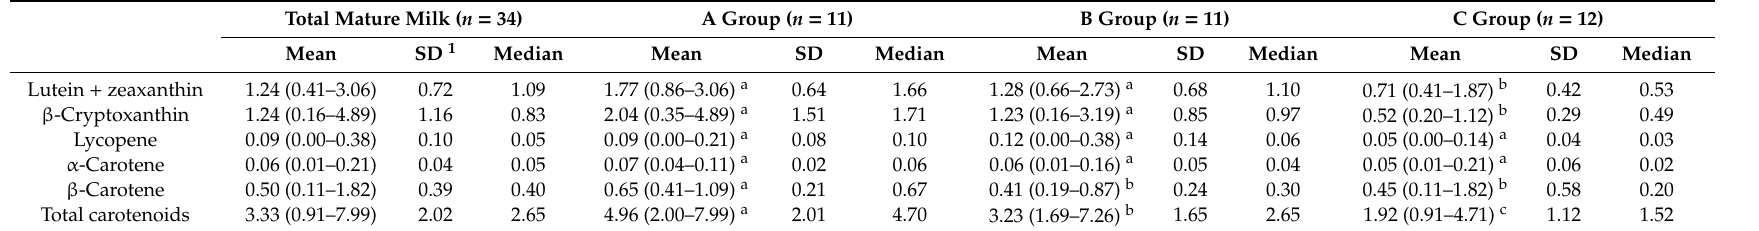
Table 2. Contents of carotenoids per normalized gram of fat contained in human milk from mothers in Korea ( µ g /